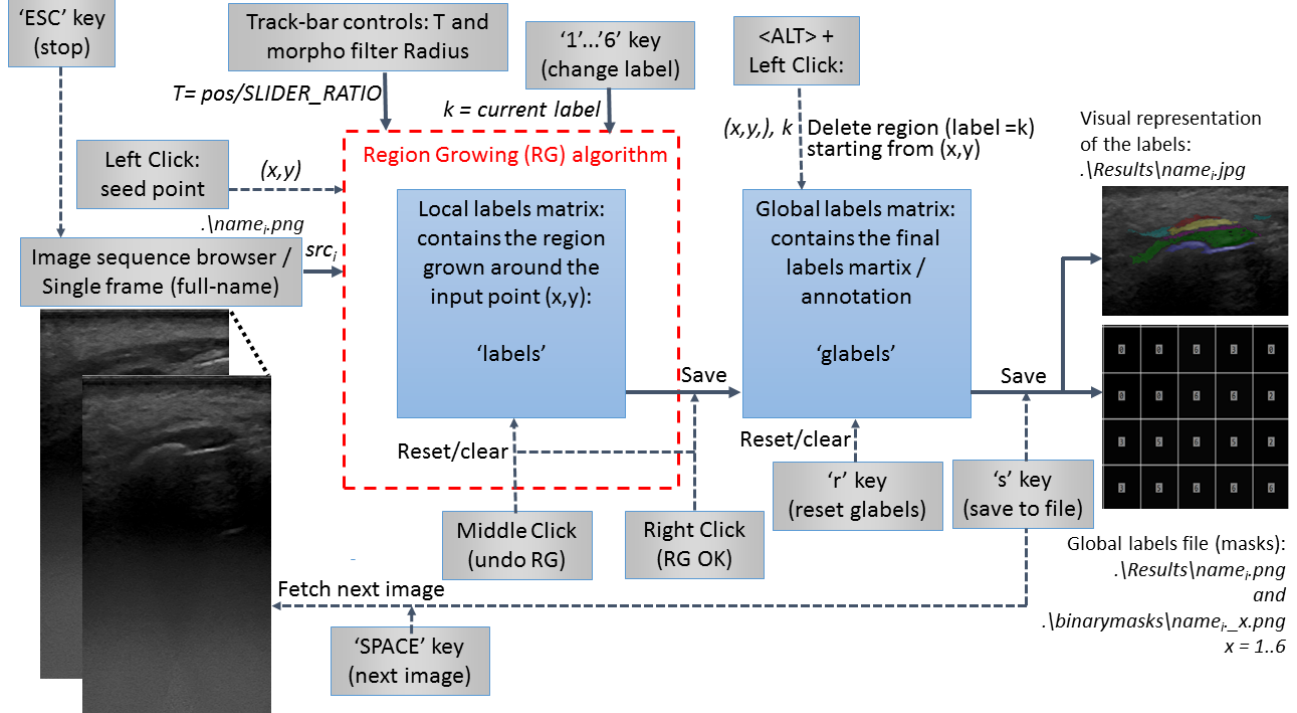
Figure 5. Flow chart of the semi-automatic annotation